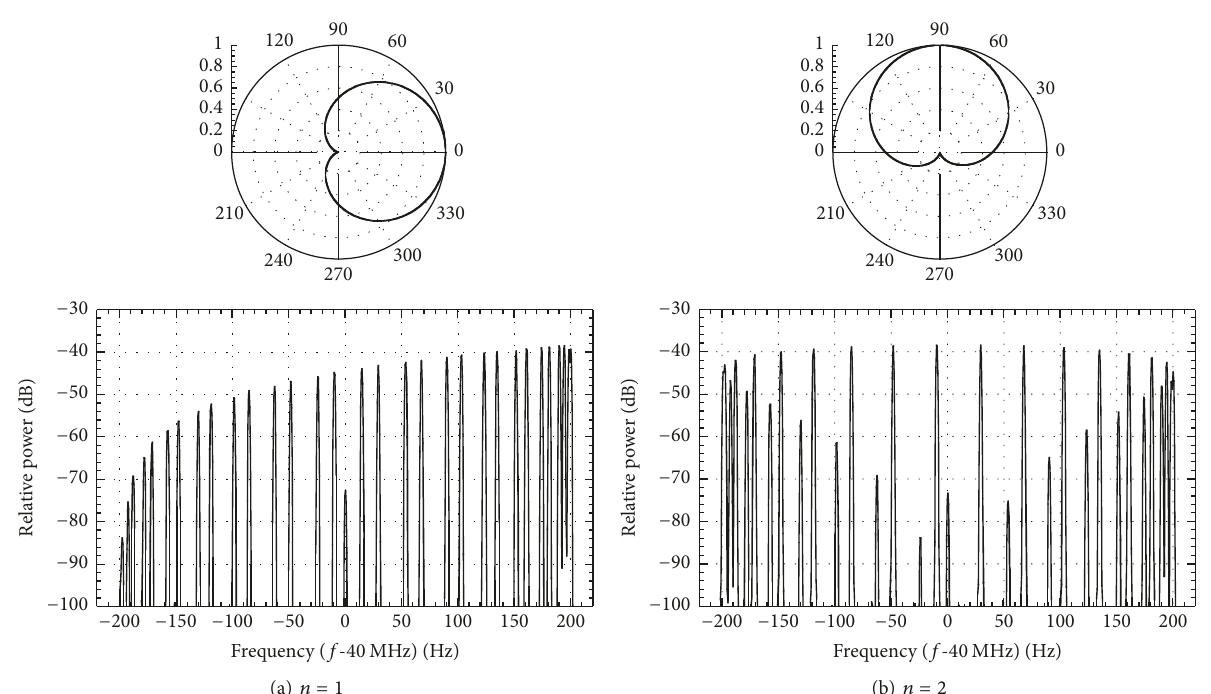
Figure 12: Receiving antenna directivity patterns and concurrent Doppler spectra.